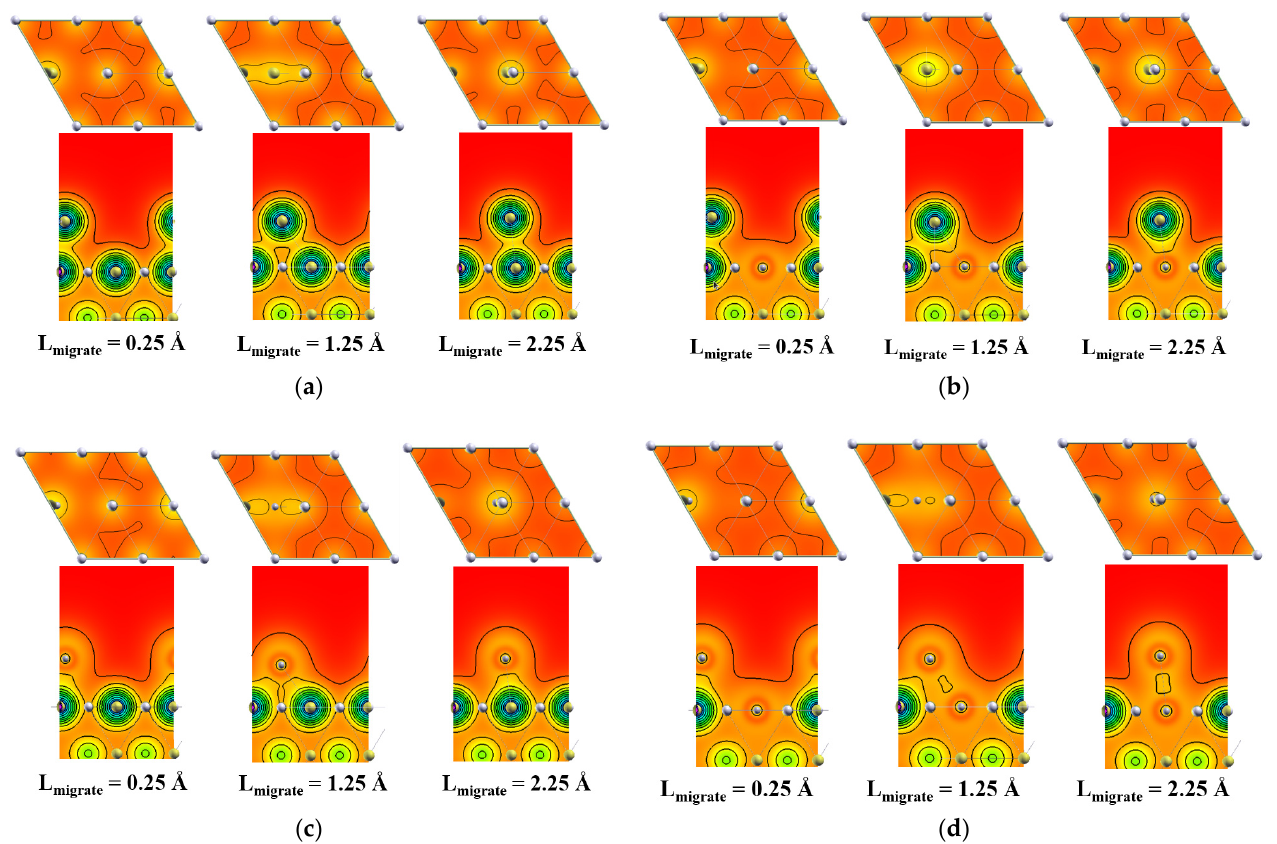
Figure 9. Top and side view of charge density potential energy isolines of adatom adsorption and migration on the Ag (111) surface along path 1. ( a ) Silver adatom migration on the pristine Ag (111) surface, ( b ) silver adatom migration on the Al-doped Ag (111) surface, ( c ) aluminum adatom migration on the pristine Ag (111) surface, ( d ) aluminum adatom migration on the Al-doped Ag (111) surface.